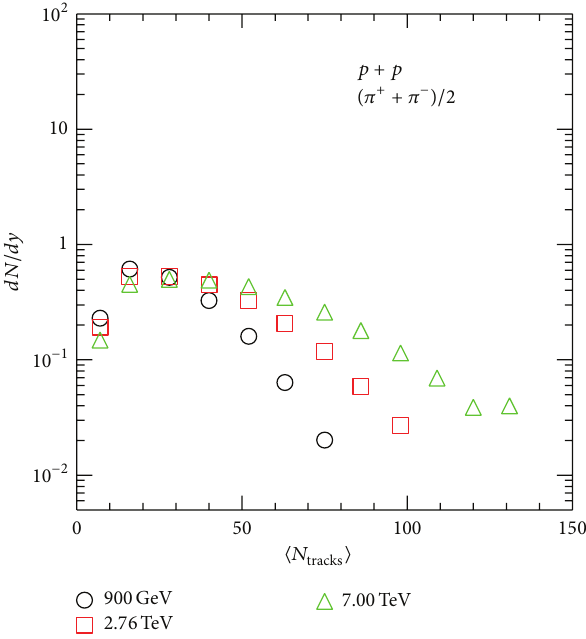
Figure 8: The variation of the Tsallis parameter 𝑛 for charged pions ⟩ .Thevariationisshownfor900 GeVbyblack asafunctionof ⟨𝑁 tracks circles, 2.76 TeV by red squares, and 7.00 TeV by green triangles. The dashed curve represents the parameterization (𝑎 + (⟨𝑁